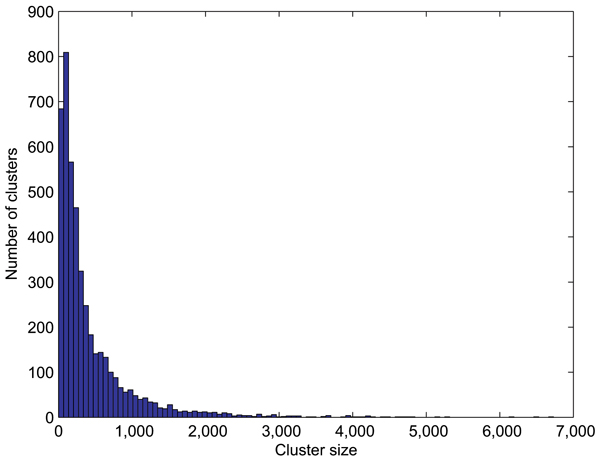
Distribution of cluster sizes. The number of residues in each cluster ranges from as few as 2 to as many as 6,731. The mean and median sizes are 437.2 and 232, respectively, and the standard deviation is 589.8. As discussed in the text, the long tail may represent internal hydrophobic environments.